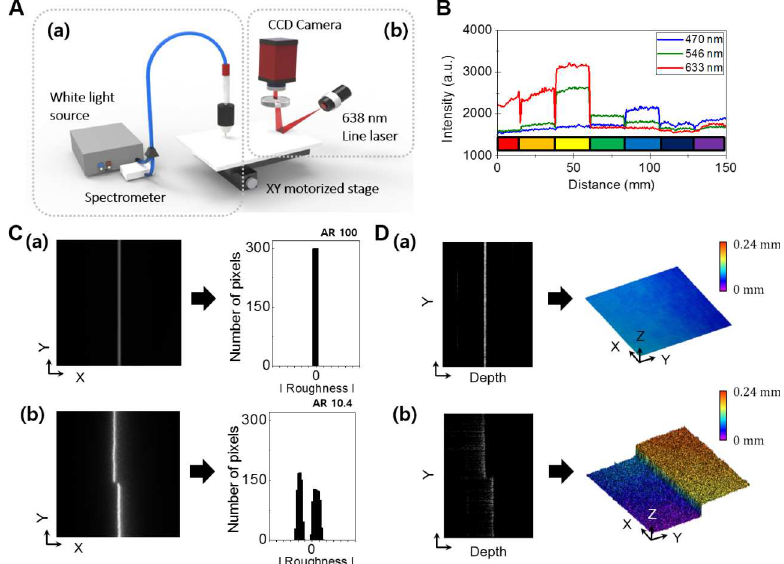
Fig 2. The schematic of optical measurement systemand pilot experiments. (A) Schematicillustrationof thesystem; (a) RGBmeasurements usinga whitelightsourceandspectrometer. (b) Topographic measurements usinga linelaserandCCD.(B) ThemeasuredRGB spectraof the rainbow-coloredimage.(C) The topographic imageobtainedfrom; (a) Silvermirror.(b) Two sheetsof A4 paper.(D) Tomographicimageand3-D topographic imageobtainedby OCT; (a) Silvermirror.(b) Twosheetsof A4